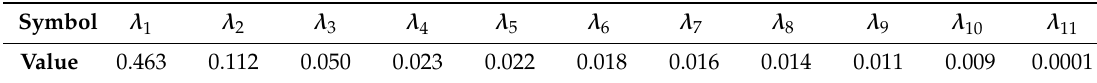
Figure 9. Envelope order spectrum of the original signal. Table 2. Singular value.